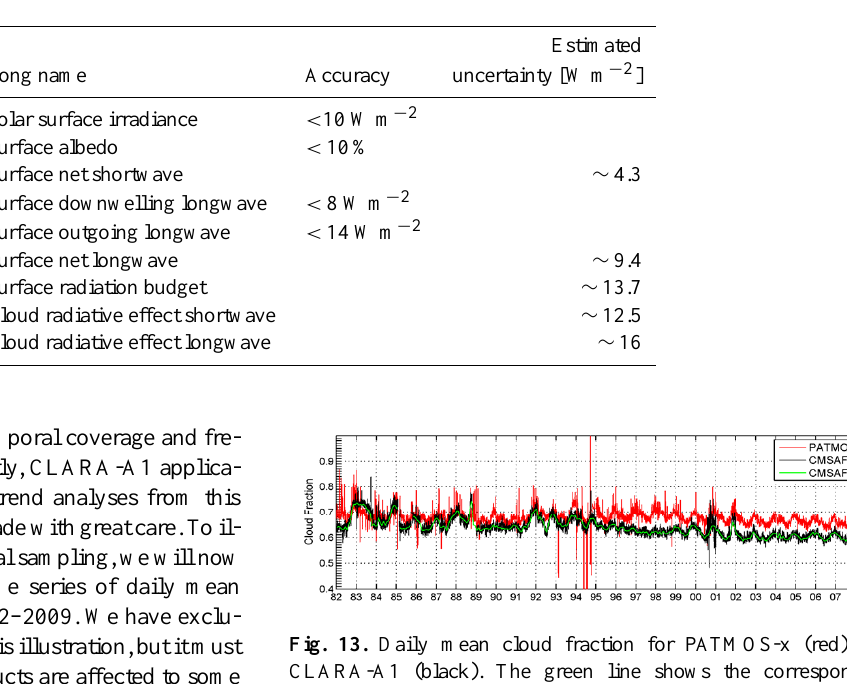
Table 3. Overview of available CM-SAF CLARA-A1 radiation datasets.The resolution of the datasets is 0 . 25 ◦ × 0 . 25 ◦ . The accuracy of the data is defined by the mean absolute differences between BSRN surface measurements and satellite-based data. The estimated uncertainties of the radiation budgets (SNL, SNS, SRB) and the cloud radiative effects are calculated by error propagation. The bias is used as input for the error propagation.